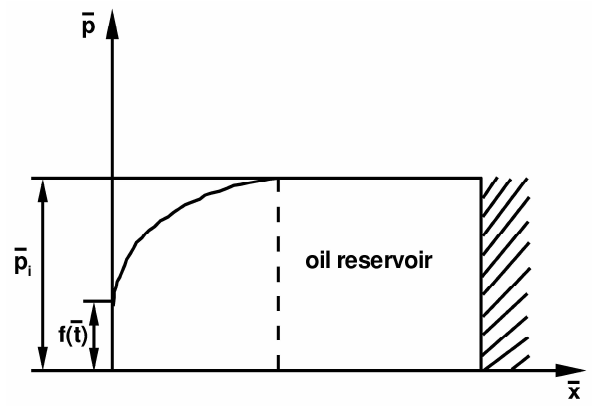
Figure 1. Schematic description of an oil reservoir.